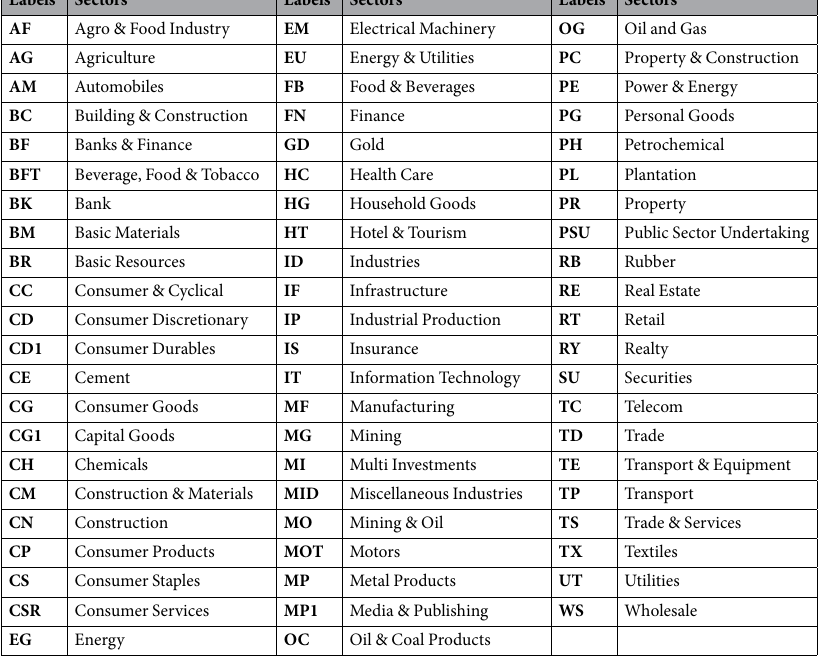
Table 1. Abbreviations of the 65 sectors